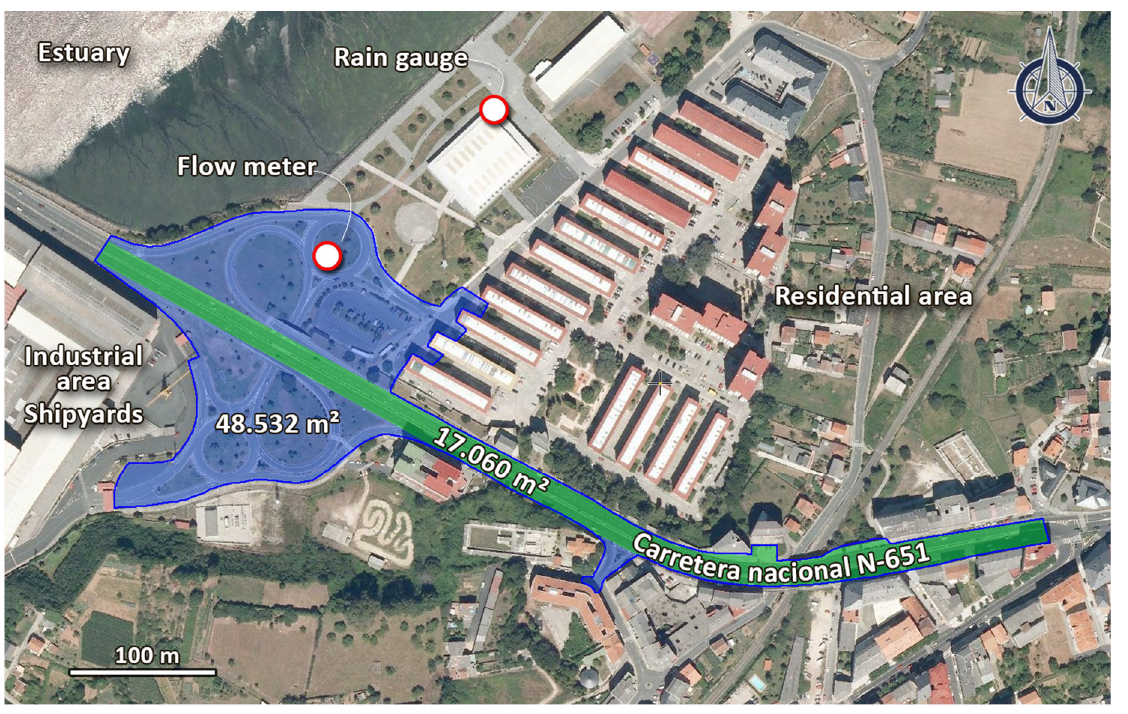
Figure 1. Road surface and adjacent areas of the study basin in Fene (A Coruña, Spain). Study basin marked in blue and green.